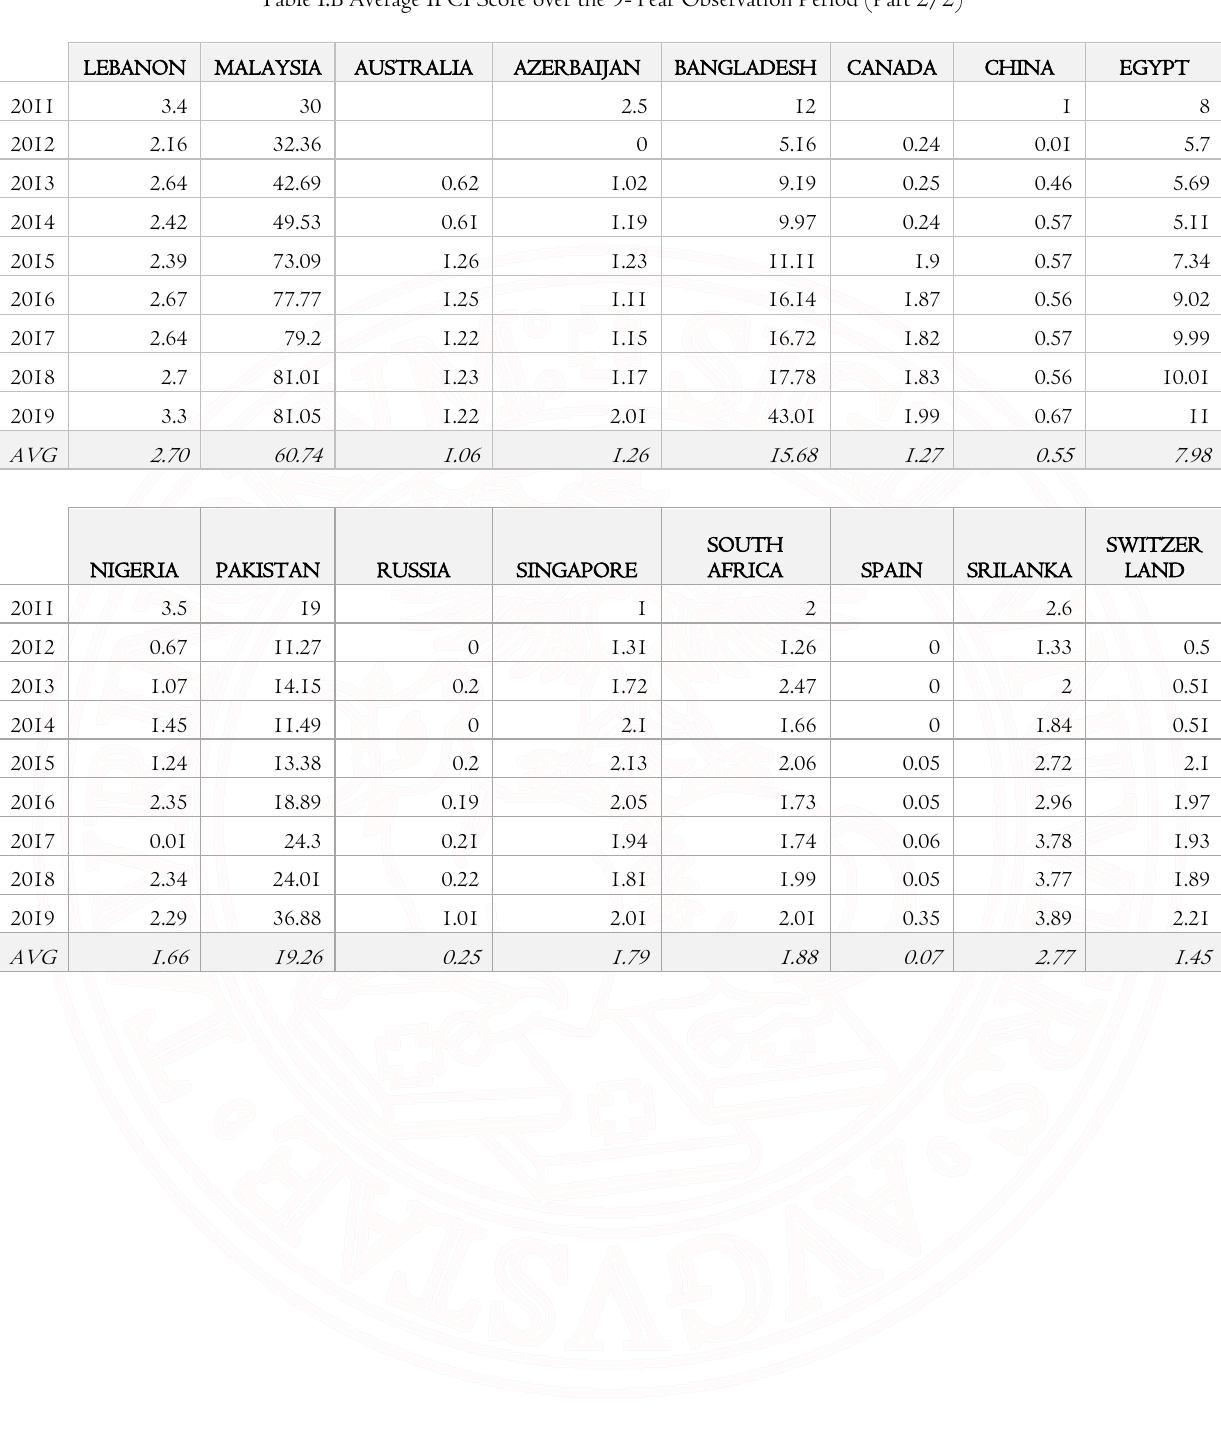
Table I.B Average IFCI Score over the 9-Year Observation Period (Part